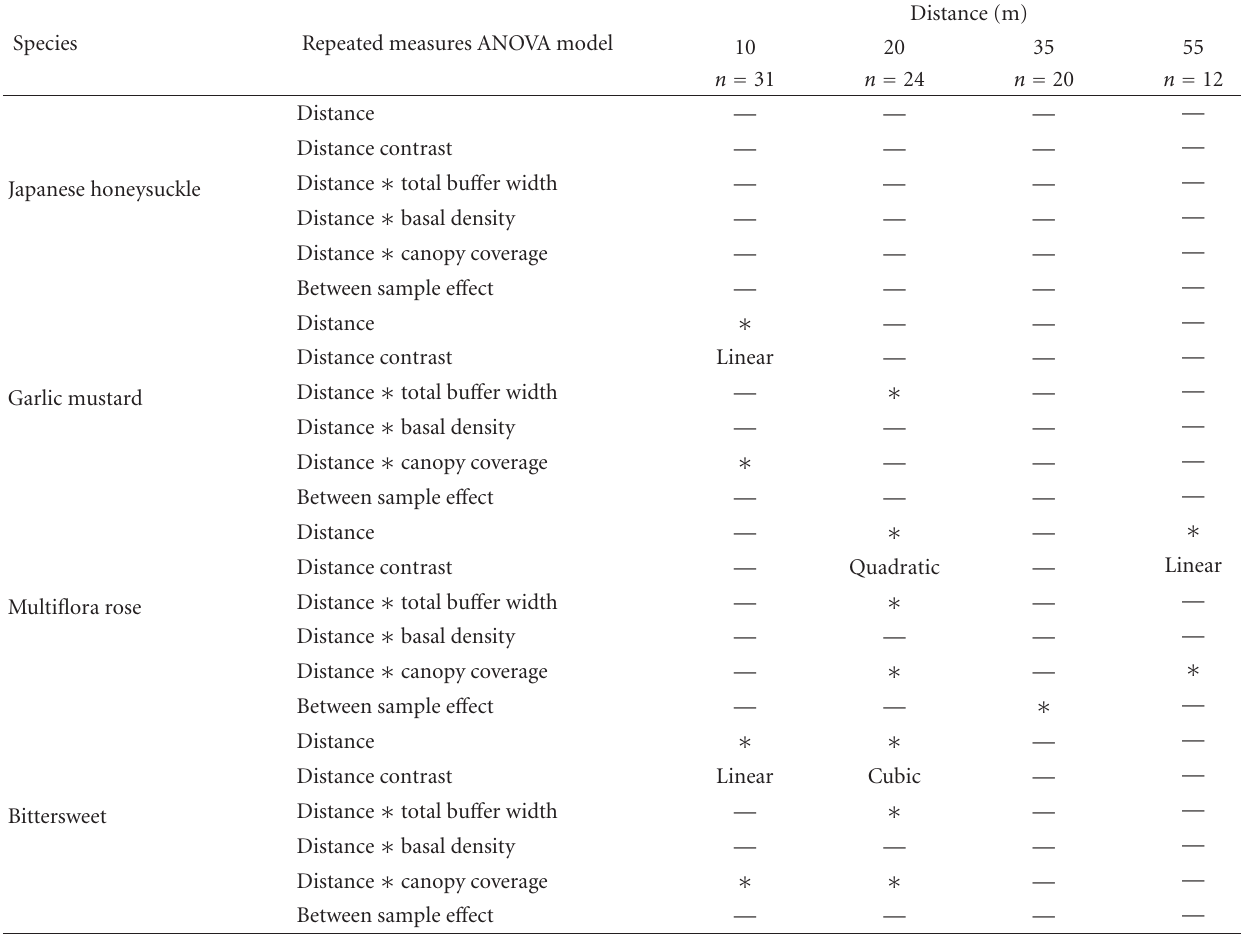
Table 1: Summary of repeated measures ANOVA models on nonnative prevalence across multiple riparian bu ff er widths in Delaware and Pennsylvania, 2007-2008. We tested for within-sample e ff ect of distance from bu ff er edge as well as the interaction between distance and total riparian bu ff er width, basal density at sampled distance, and canopy coverage at sampled distance. Stars indicate significance ( P ≤ 0 . 10). We further tested for trends across bu ff er width exhibiting significant ( P ≤ 0 . 10) linear, quadratic, or cubic relationships.